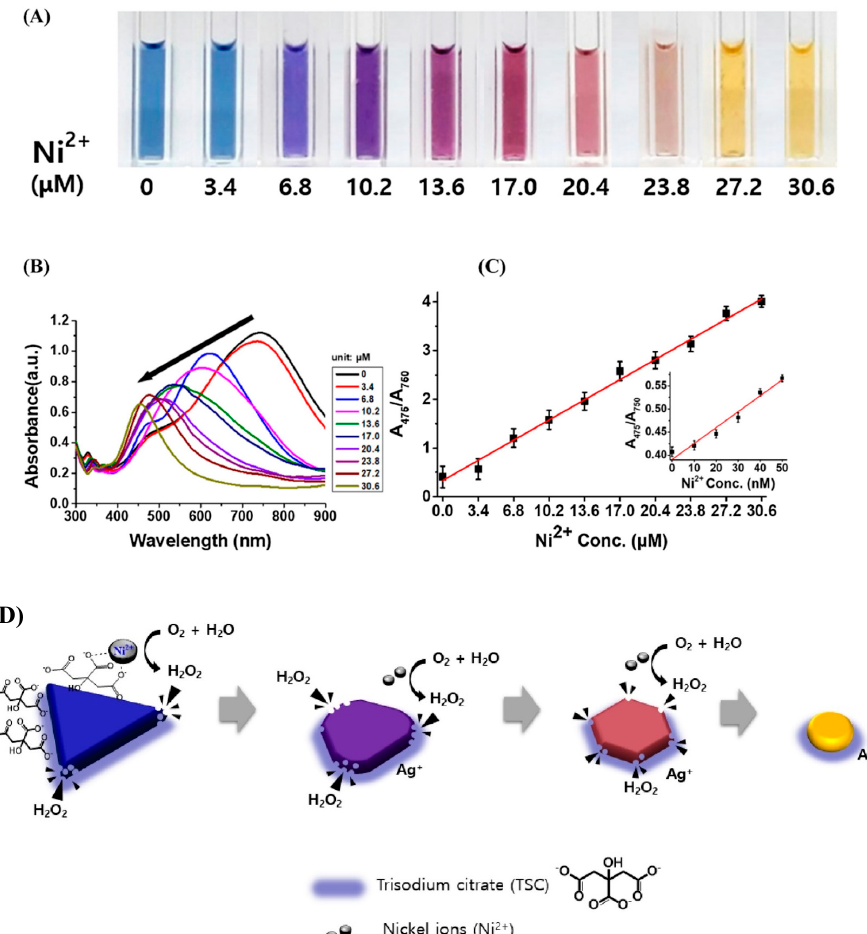
Figure 8. ( A ) Color change of the triangular silver nanoprisms upon addition of 10 different concentrations of Ni (II) (0.0 to 30.6 μ M) at pH 8 and 15 °C; ( B ) UV-vis absorption spectra of the colloidal solutions as a function of Ni (II) concentration; ( C ) absorption ratios (A475/A750) from the UV–vis absorption spectra as a function of the Ni (II) ion concentration (0.0 to 30.6 μ M). The inset shows the same absorption ratios but for lower concentrations of Ni (II); ( D ) The sensing mechanism of citrate-capped triangular AgNPrs for Ni(II) ions. (Reference. [127]).